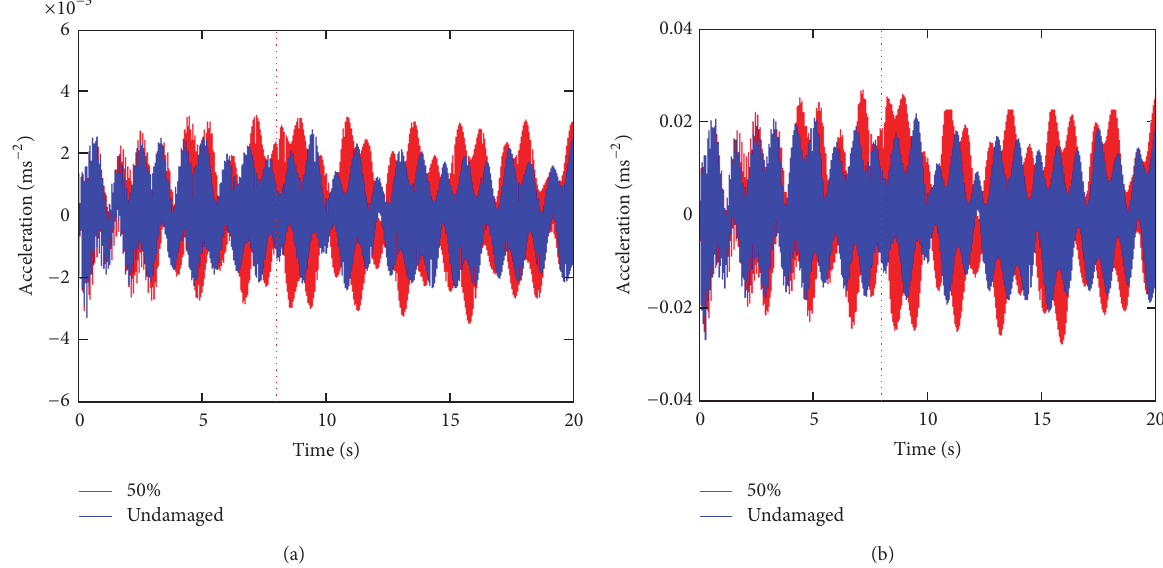
Figure 10: Acceleration responses: (a) the mass is 50 Kg and (b) the mass is 400 Kg.